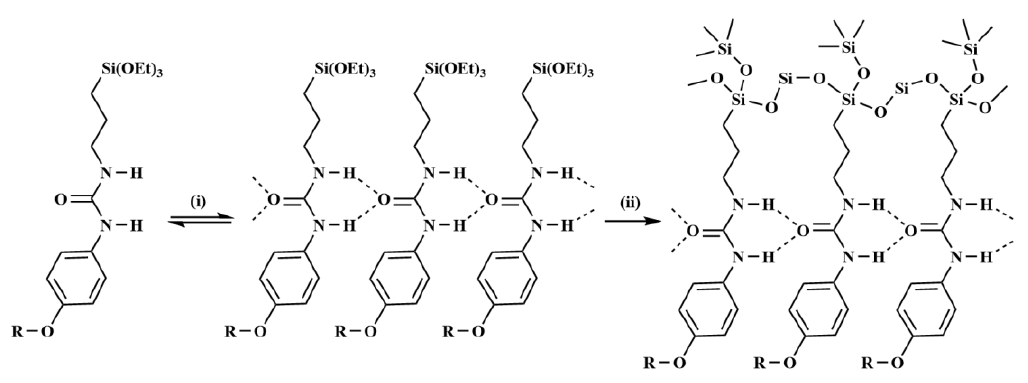
Figure 2. Self-organization process of organic–inorganic hybrid functional materials.